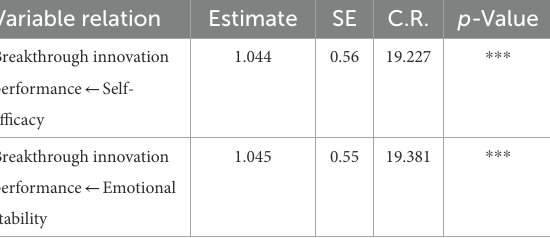
TABLE 7 Regression analysis of self-efficacy and knowledge sharing on breakthrough innovation performance.